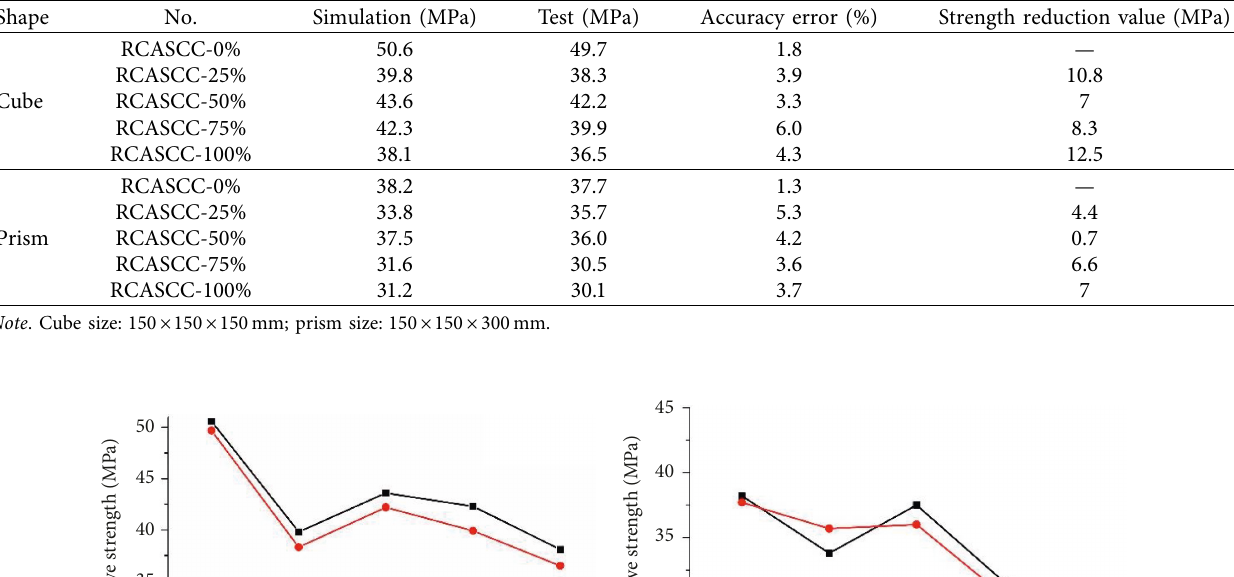
Table 2: Compressive strength.